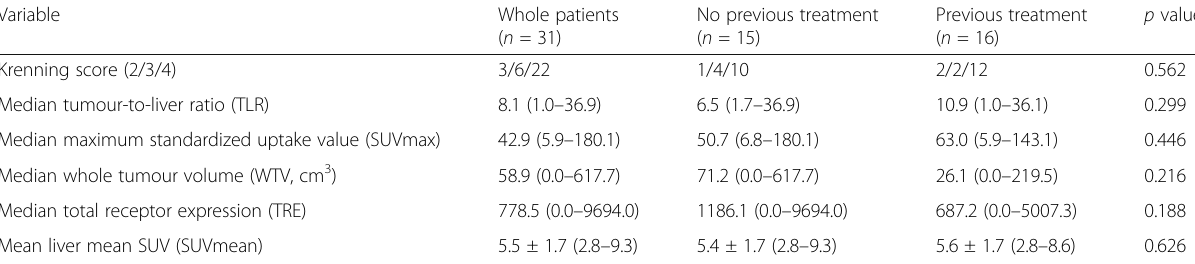
Table 2 Summary and comparison of [ 68 Ga]Ga-DOTA-TOC PET/CT results Variable